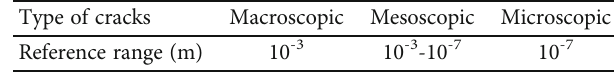
Figure 4: Relative water absorption rate of threshold stage. Table 1: Reference range of scales with the